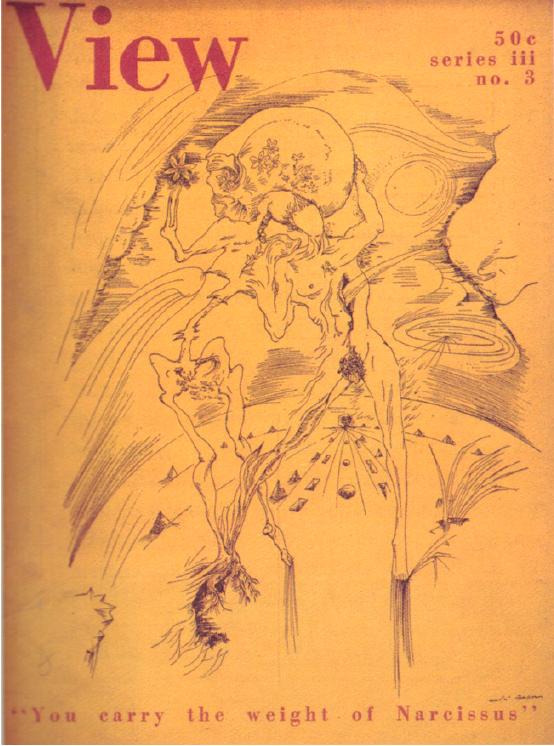
Figure 7. André Masson, You Carry the Weight of Narcissus , View , October 1943. © 2020 Artists Rights Society (ARS), New York/ADAGP, Paris. Used with permission.